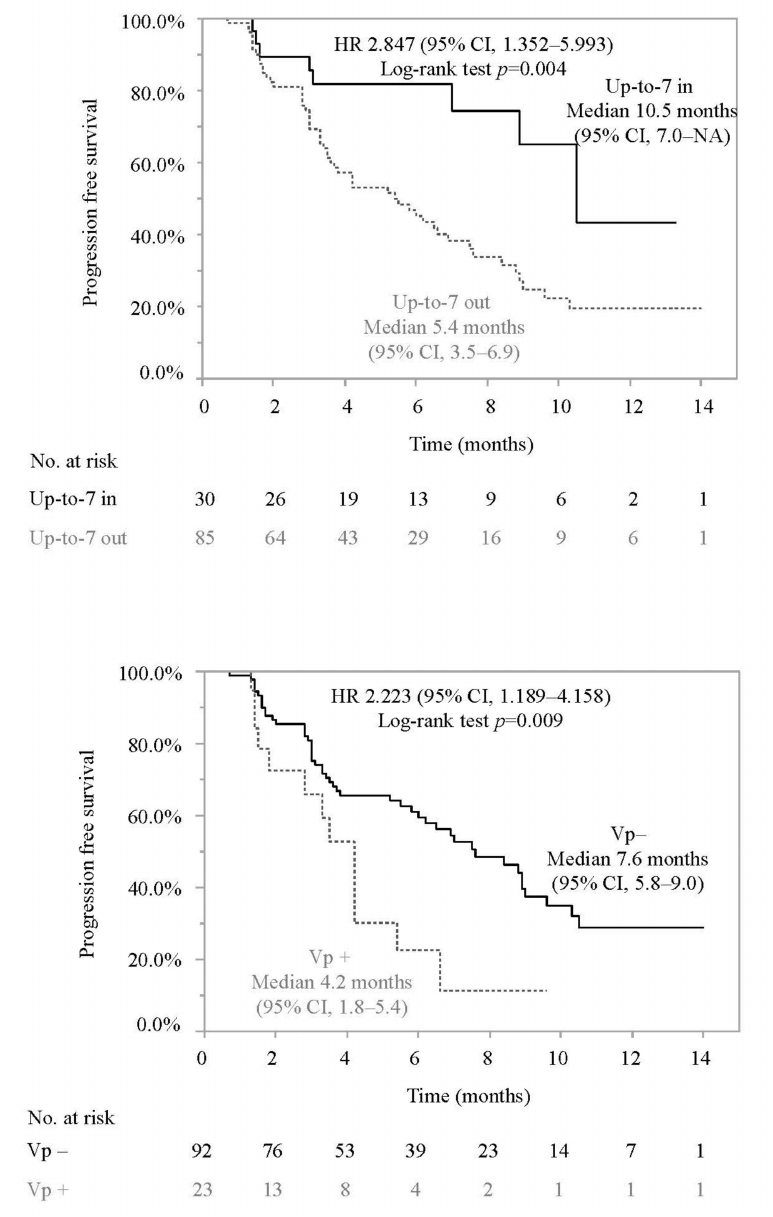
Figure 2. Comparison of progression-free survival in each subgroup. Survival curves for PFS were calculated by the Kaplan-Meier method and compared using the log-rank test. HR: Hazard Ratio, 95% CI: 95% confidence interval, NA: not applicable, BCLC: Barcelona Clinic Liver Cancer, mALBI: modified albumin-bilirubin grade, Vp: portal vein